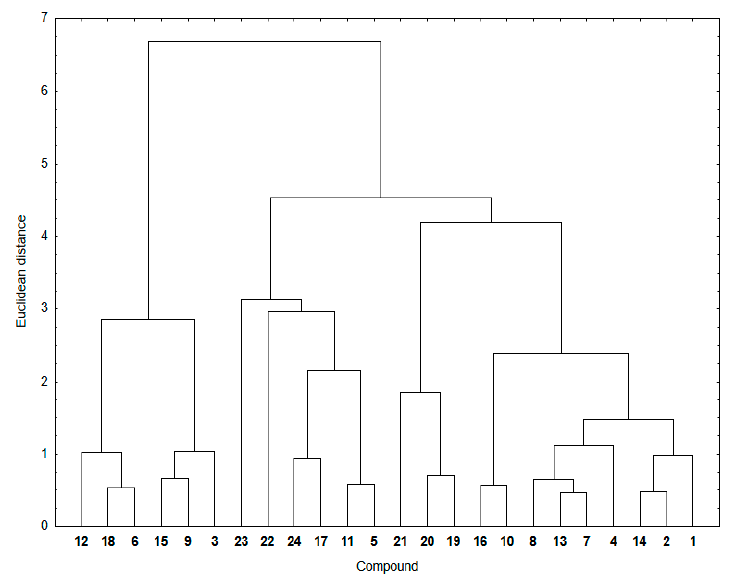
Figure 5. Similarity analysis for the ADMET parameters and experimental lipophilicity for com- pounds 1 – 24 .